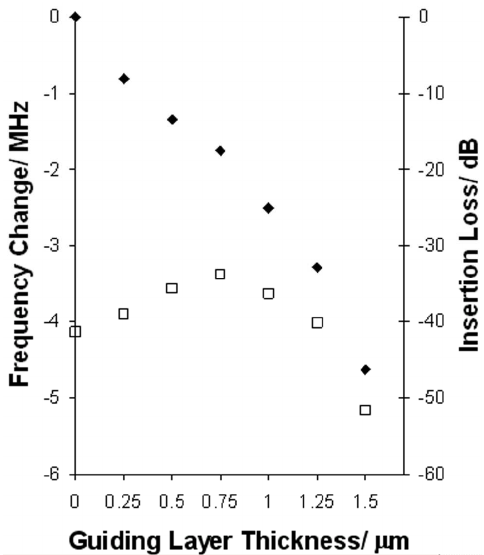
Figure 2. Insertion loss (open squares) and frequency change (solid diamonds) as a function of polymer guiding layer thickness showing the reduction in insertion loss up to 0.75 m